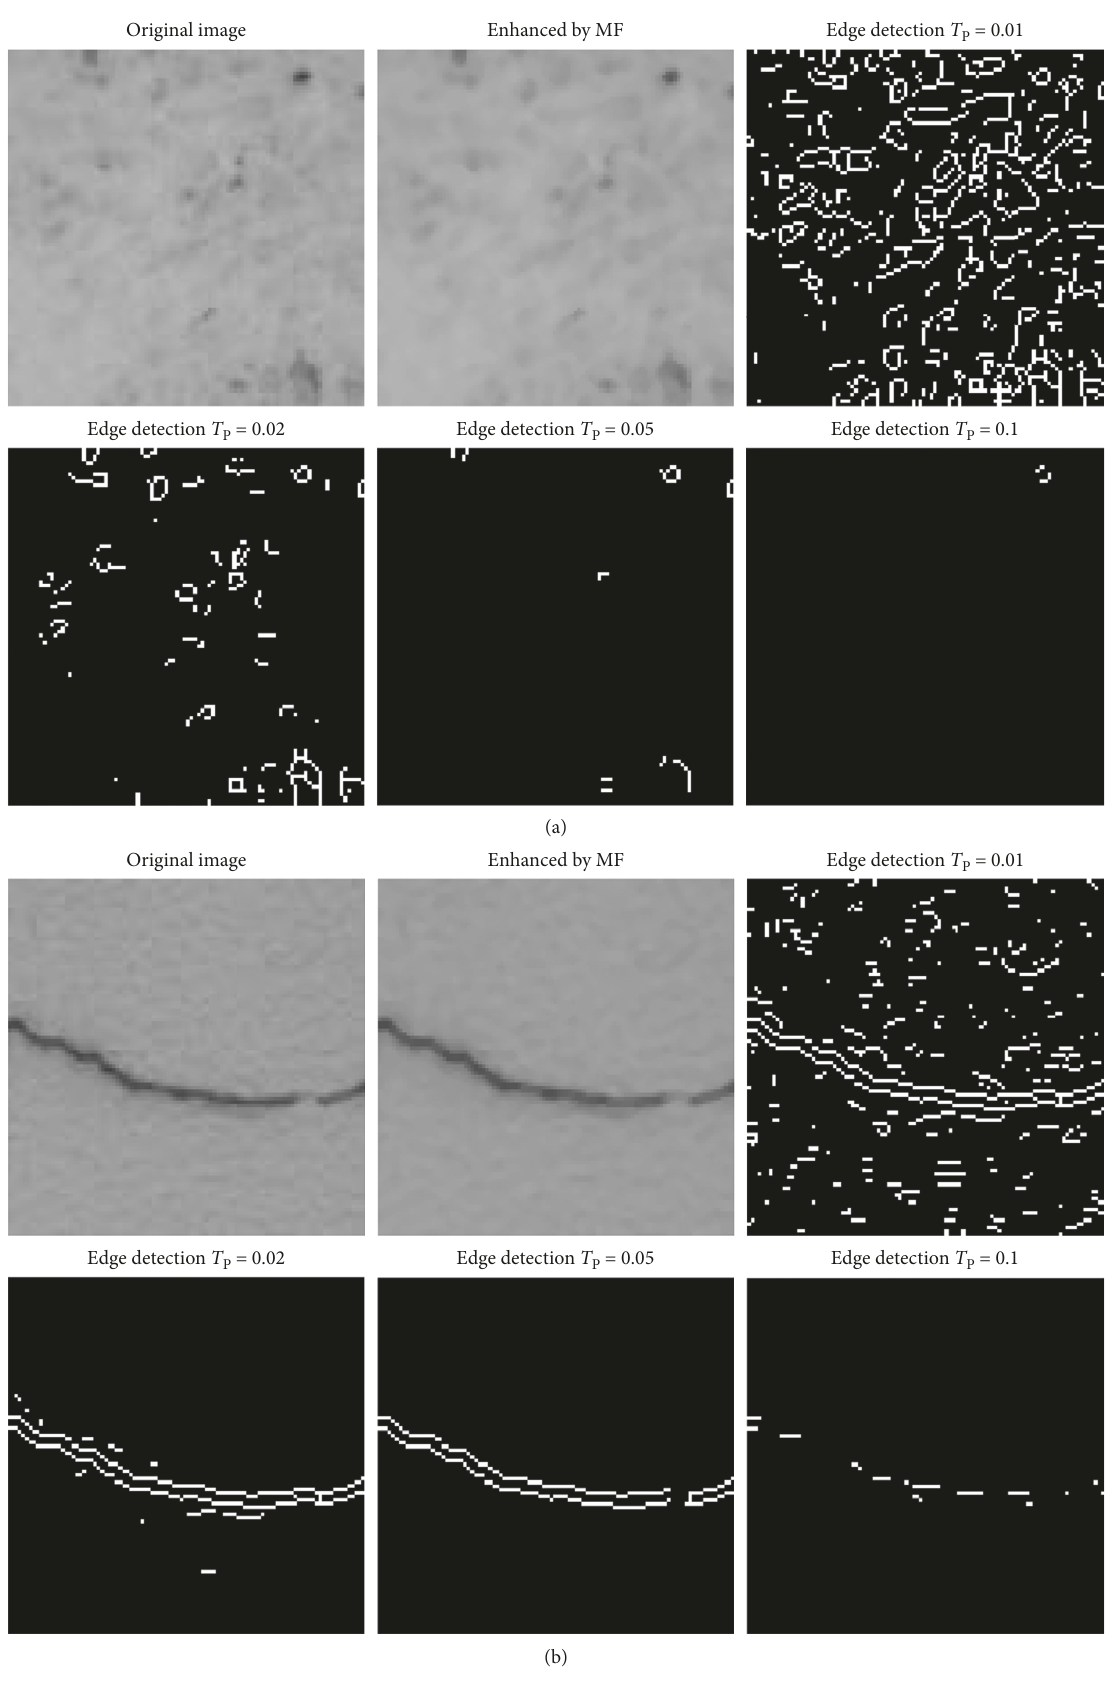
Figure 2: Edge detection result using the Prewitt method: (a) an image without cracks and (b) an image with